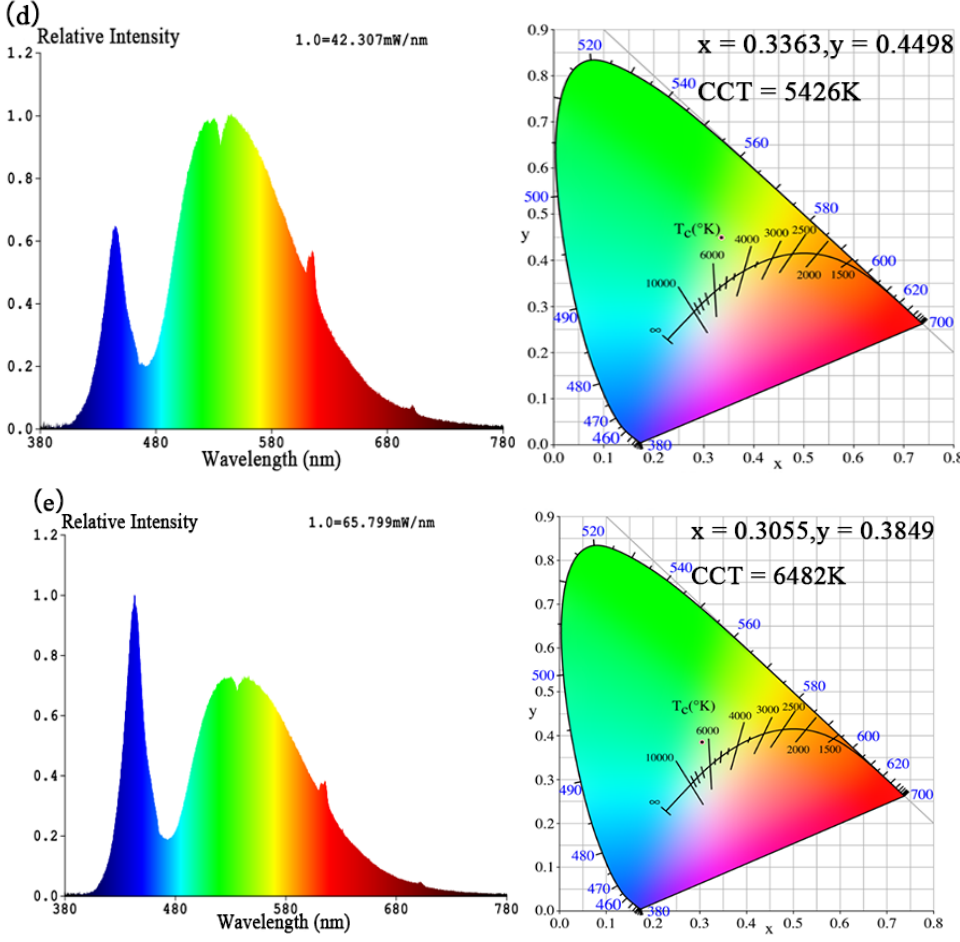
Figure 12. The emission spectra and CIE diagrams of the WLED lamps coated with LL 0.83 M:0.05Sm 3+ ,0.12Eu 3+ red phosphors and commercial yellow phosphors of different mass ratios,